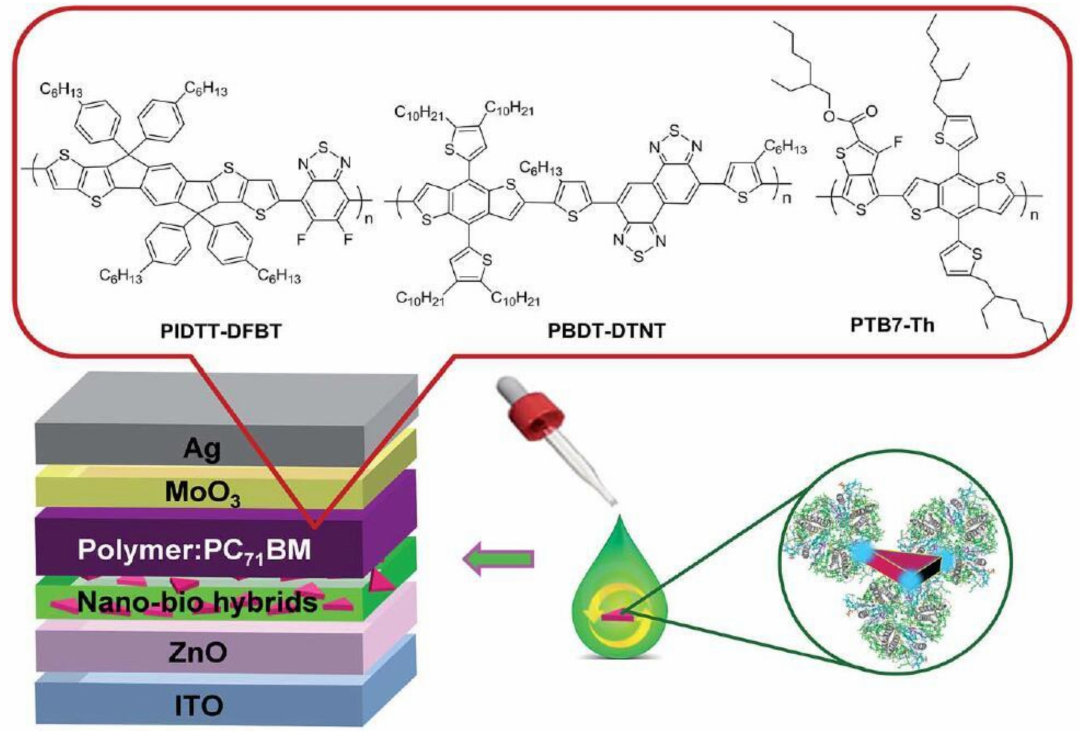
Figure 8. Schematic illustration of the OPV devices incorporating the interlayer of nano-bio hybrids between ZnO and the active layer. The insets show the crystal structure of LHCII, and chemical structures of polymers PIDTT-DFBT, PBDT-DTNT, and PBT7-Th [55]. Reprinted with permission from Ref.